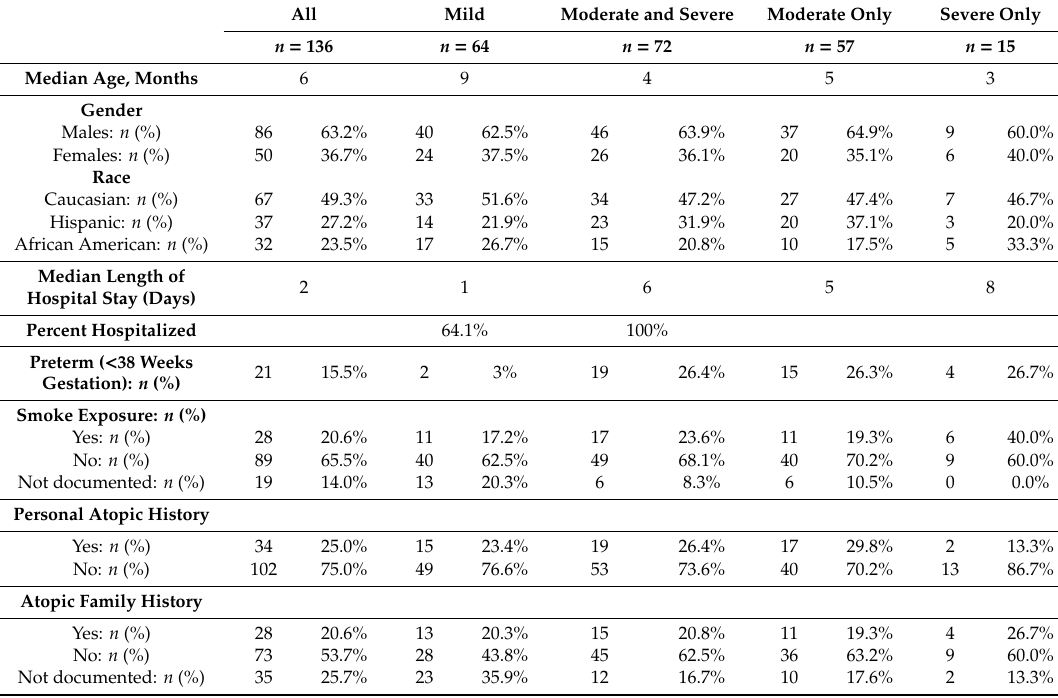
Table 1. Baseline demographics by disease